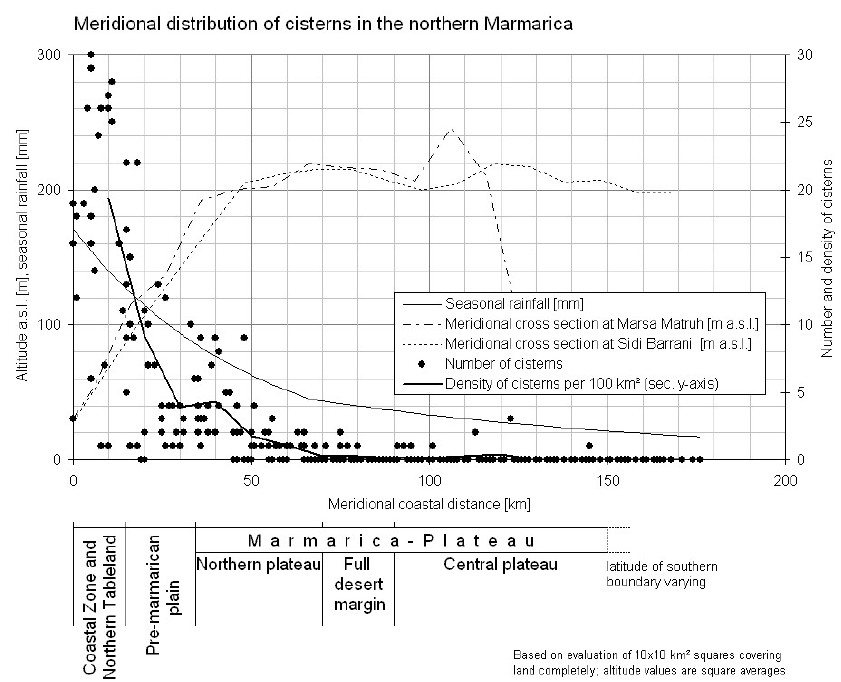
Figure 11. Cistern density in the area between Sidi Barrani/Ainesisphyra and Marsa Matruh/Paraitonion in recent times in correlation to mean rainfall, relief, and coastal distance. A high number of the cisterns on the tableland date back to Roman times, whereas the surveyed cistern sites on the Marmarica Plateau show evidence of older periods. Graph: T. Vetter.